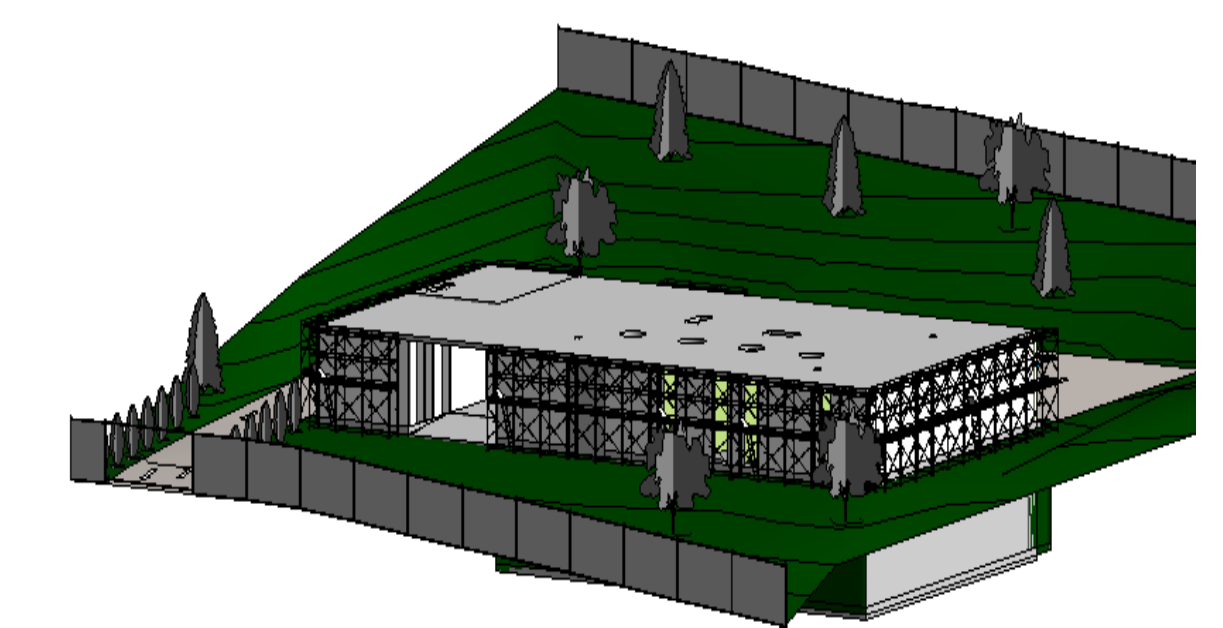
Figure 3. Architecture 3D model with safety equipment.